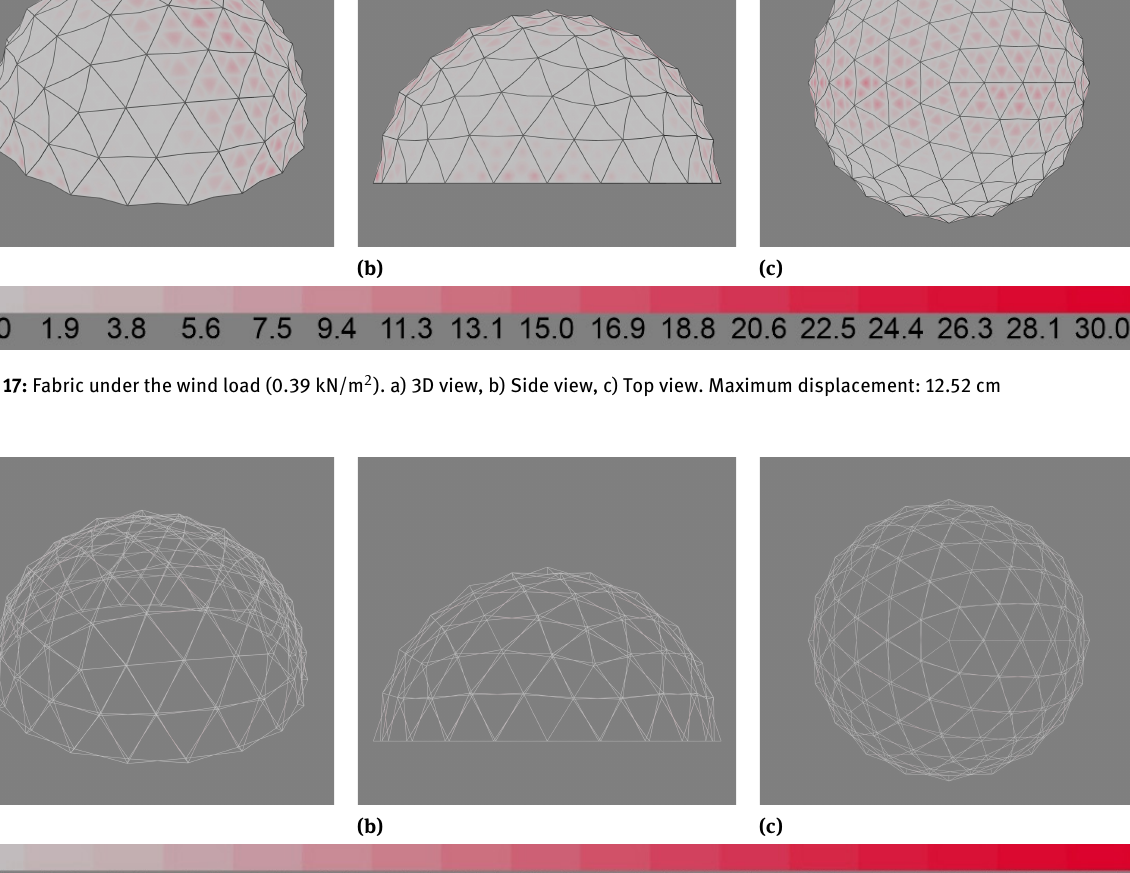
On the graph below, these 3 values are shown as the